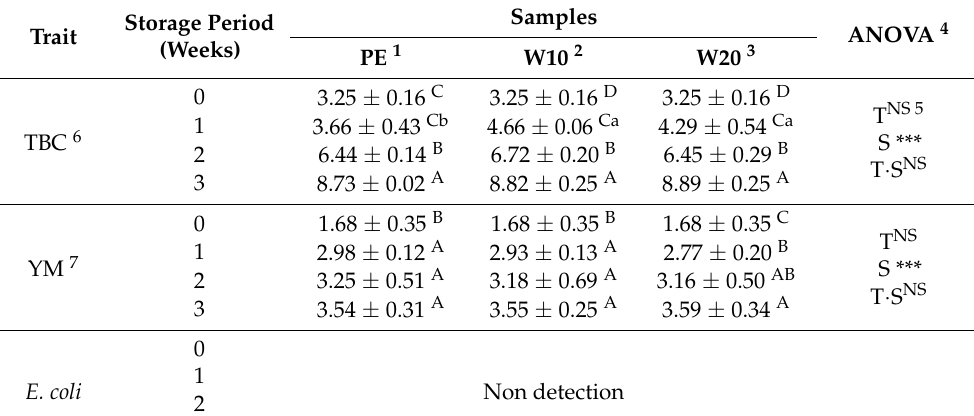
Table 4. Microbial populations (log colony-forming unit/kg) of sausages stored in the PE and biodegradable containers manufactured with walnut shell